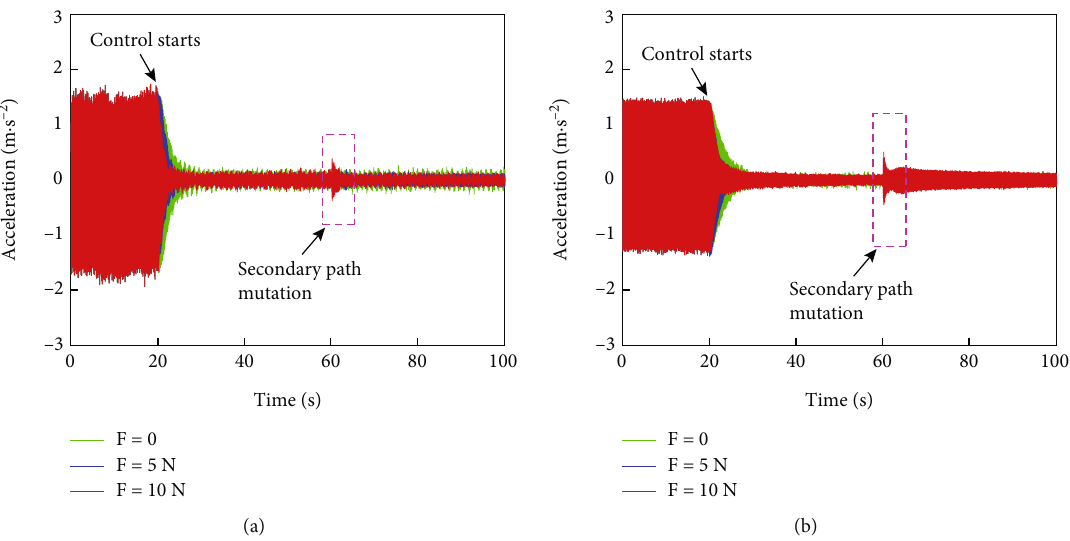
Figure 13: Acceleration response with LMS-IOBR. (a) 1# point. (b) 2#